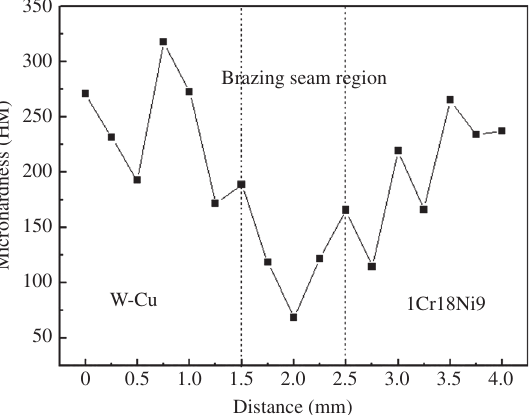
Figure 3 Microhardness distribution near the interface of the brazed